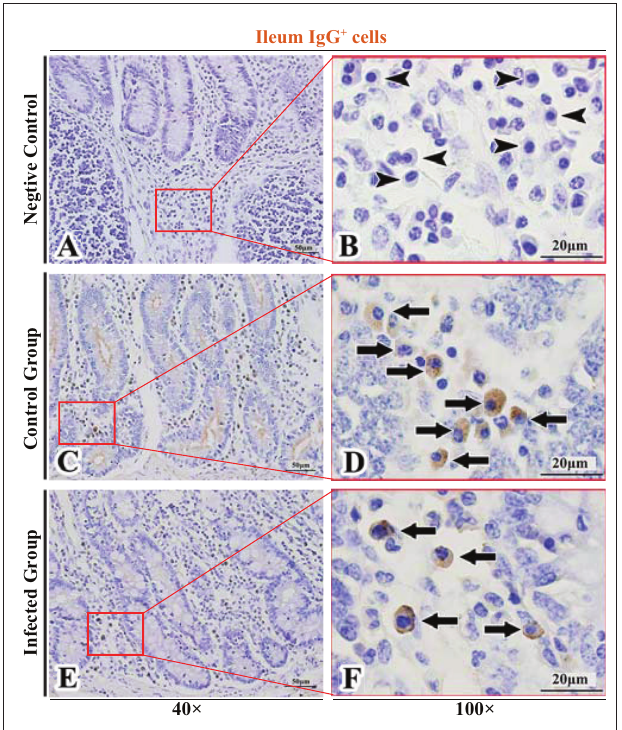
FIGURE 10 | Distribution of IgM + cells in sheep ileum. (A,B) are negative controls; (C,D) are Control groups; (E,F) are Infected groups. Triangular arrows indicated plasma cells, arrows indicated IgM + cells, and the right image (Scale bar, 20 µ m) is a magnification from the part of the left image (Scale bar, 50 µ m).